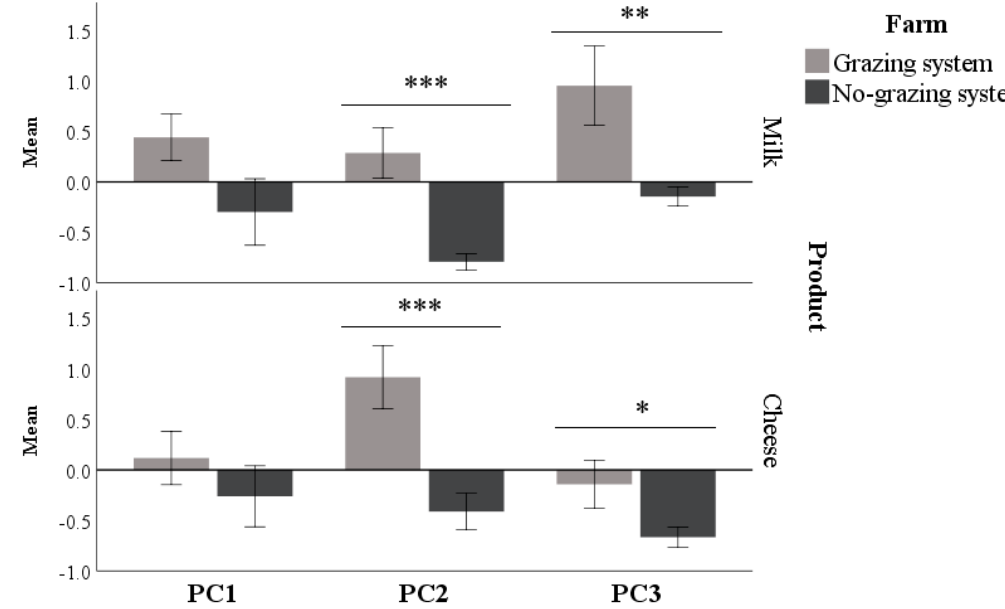
Figure 3. Mean ± standard error of the component (PC) scores in milk (top panel) and cheese (lower panel) of grazing and no grazing farms. “PC1. C < 18 − C18” had positive loadings for saturated and monounsaturated fatty acids with 18 carbon atoms; “PC2. C18 PUFA & C15” included PUFA n6 and n3 with 18 carbon atoms in addition to pentadecanoic acid. PC3. C > 18 & CLA had positive loadings for fatty acids containing 20 or more carbon atoms and for the conjugated linoleic acid.